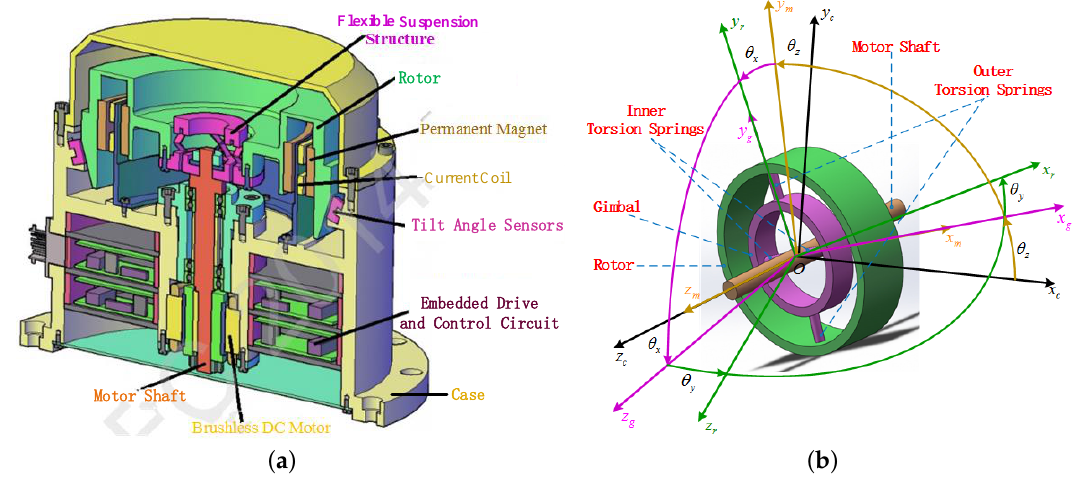
Figure 1. Gyrowheel physical structure. ( a ) Schematic diagram of a gyrowheel system; ( b ) simplified gyrowheel structure diagram.